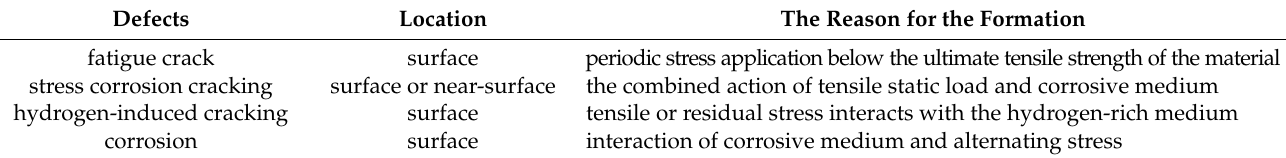
Table 2. Defects of pipelines produced during operation and their causes [4,5,15,16,19,28].